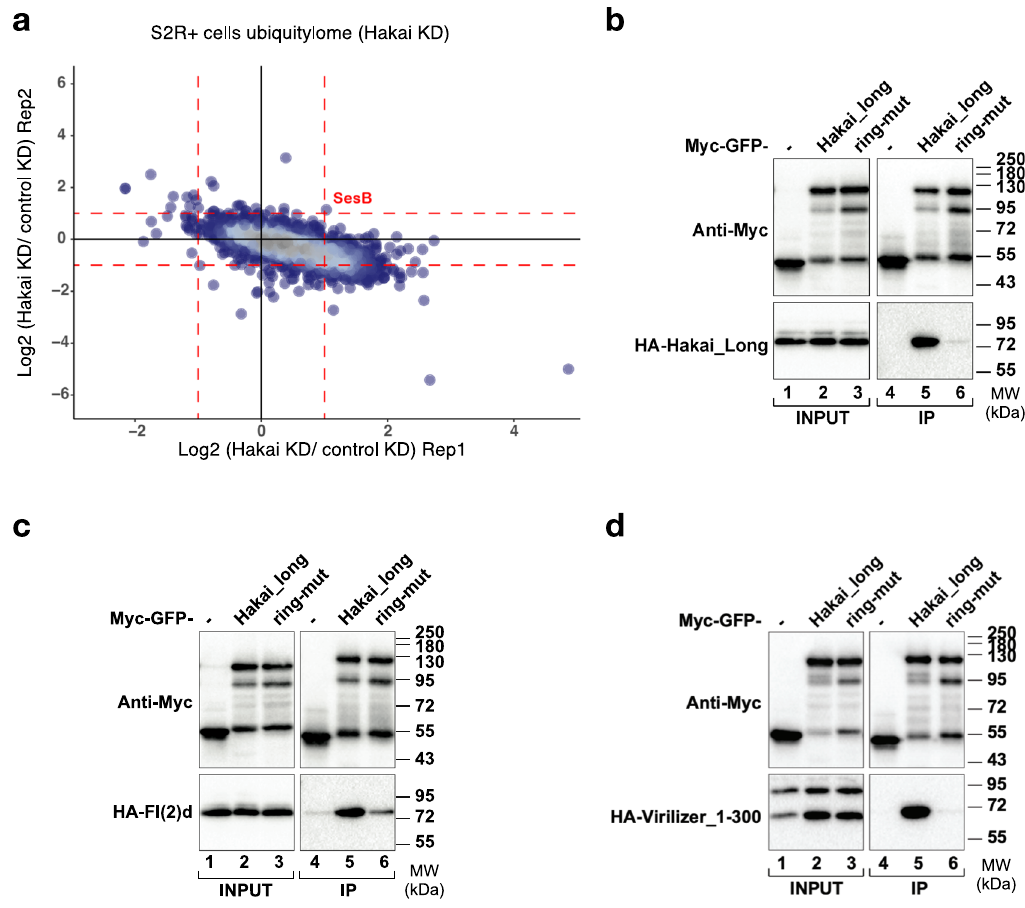
Fig. 5 Hakai RING domain is required for interaction with MACOM components. a Mass spectrometry analysis of Hakai-dependent ubiquitinated proteins in S2R + cells. Scatter plot of normalized forward versus inverted reverse experiments plotted on a log2 scale. The threshold was set to a twofold enrichment or depletion (red dashed line). One protein in the top right quadrant is enriched in both replicates. Hakai depletion does not affect global ubiquitination levels in D. melanogaster S2R + cells. A complete list of quanti fi ed ubiquitylation sites after HAKAI depletion can be found in Supplementary Data 3. b – d Co-immunoprecipitation experiments were carried out with lysates prepared from S2R + cells transfected with Myc-GFP-tagged Hakai-long (WT or RING mutant) and HA-tagged Hakai-long ( b ), HA-tagged Fl(2)d ( c ) and HA-tagged Virilizer fragment ( d ). In control lanes, S2R + cells were transfected with Myc-GFP alone and an identical HA-containing protein. Extracts were incubated with magnetic GFP binder beads and immunoblotted using anti-Myc and anti-HA antibodies, as indicated. Two percent of input was loaded. The experiment was performed in the presence of RNase A. Images shown are representative of two biological replicates. Source data for Western blots are provided as a Source Data fi